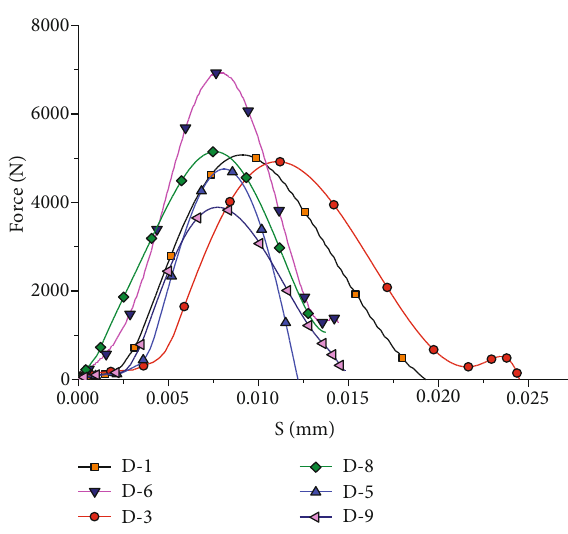
Figure 5: Load-displacement curves of di ff erent loading